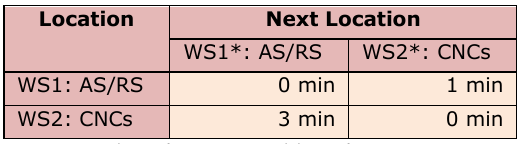
Table 4. Transportation time between work